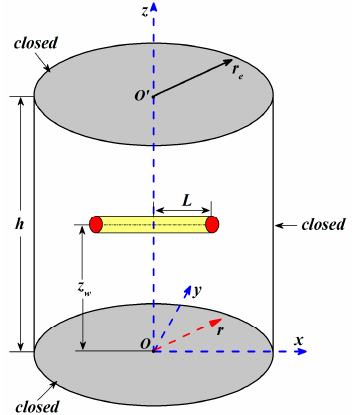
Figure 1. Horizontal well model in the closed cylindrical system.